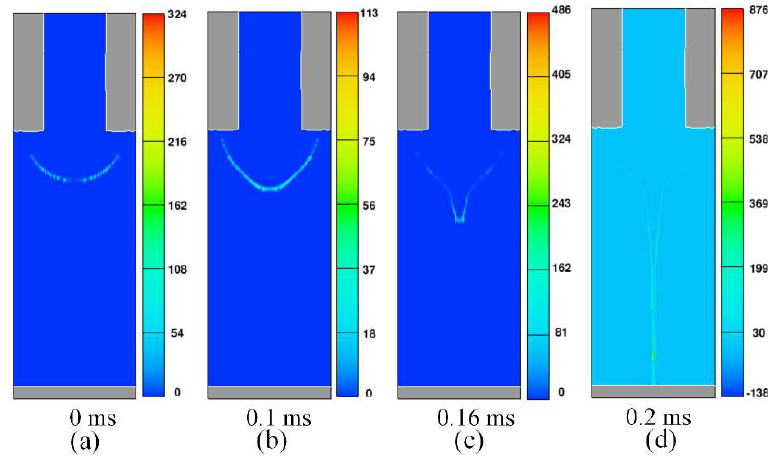
Figure 5. ( a – d ) Charge density distribution at four representative moments during an injection cycle.